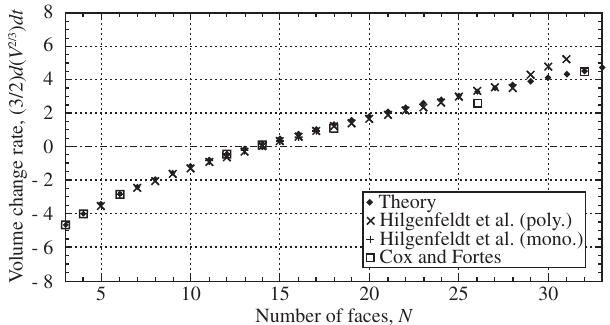
Figure 6. Comparison of the theoretical scale-free rates of volume change for various ANHs with Surface Evolver simulation data. The data from Cox and Fortes 7 are Surface Evolver simulations of isolated N -hedra, whereas the data from Hilgenfeldt et al. 14 are based on Surface Evolver simulations of irregular isotropic network structures containing over 500 polyhedral cells.